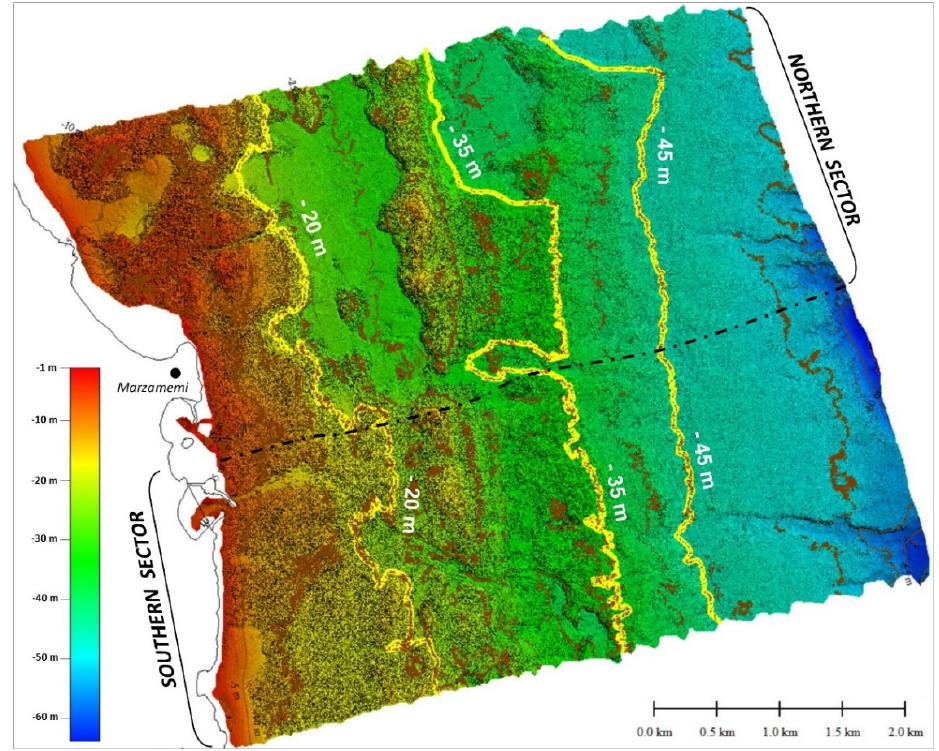
Figure 5. Multibeam dataset. The black dashed line divides the southern sector from the northern one. The yellow lines represent the 3 contours assumed to be the markers of the locations of the key paleo-coastlines.